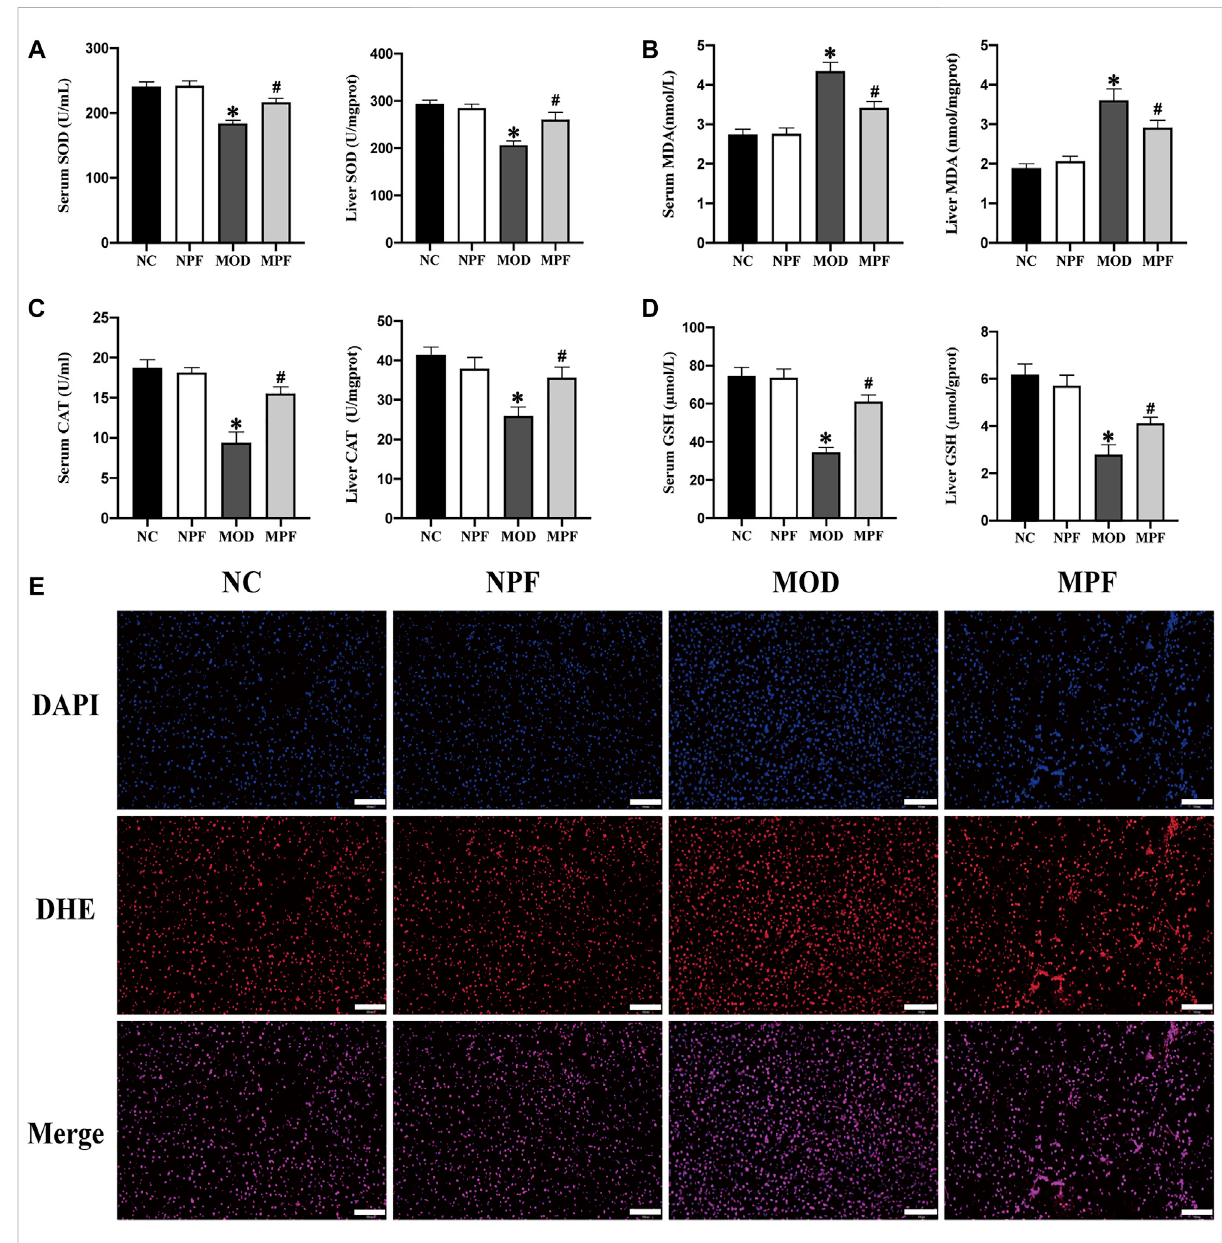
Effects of paeoni fl orin (PF) on oxidative stress indicators in the serum and liver. (A) Serum and liver SOD activity. (B) Serum and liver MDA content. (C) Serum and liver CAT activity. (D) Serum and liver GSH content. (E) Representative reactive oxygen species (ROS) histologic slices in four groups,(200×,scalebar=100 μ m).Theserumandliversampleswereobtainedfromthenormalcontrolgroup(NC),PF-treatedcontrolgroup(NPF), model group (MOD), and PF-treated model group (MPF). Data are presented as the mean ± S.E.M ( n = 10). * p < 0.05 VS. NC and # p < 0.05 VS.